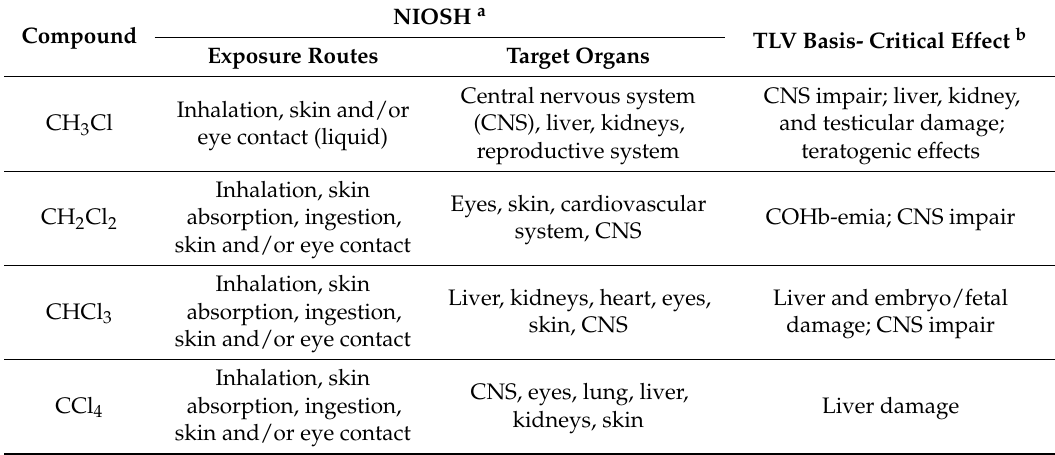
Table 2. Hazards of chloromethanes to human